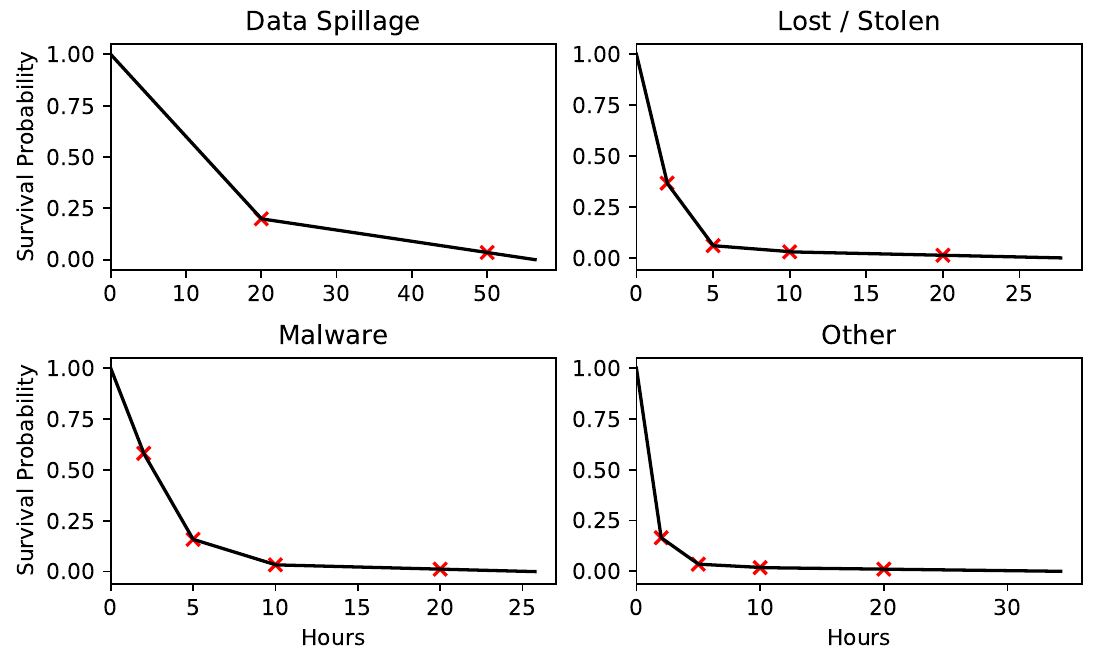
Figure 6. In red are points found from averaging the data, interpolated in black are the survival functions used in the